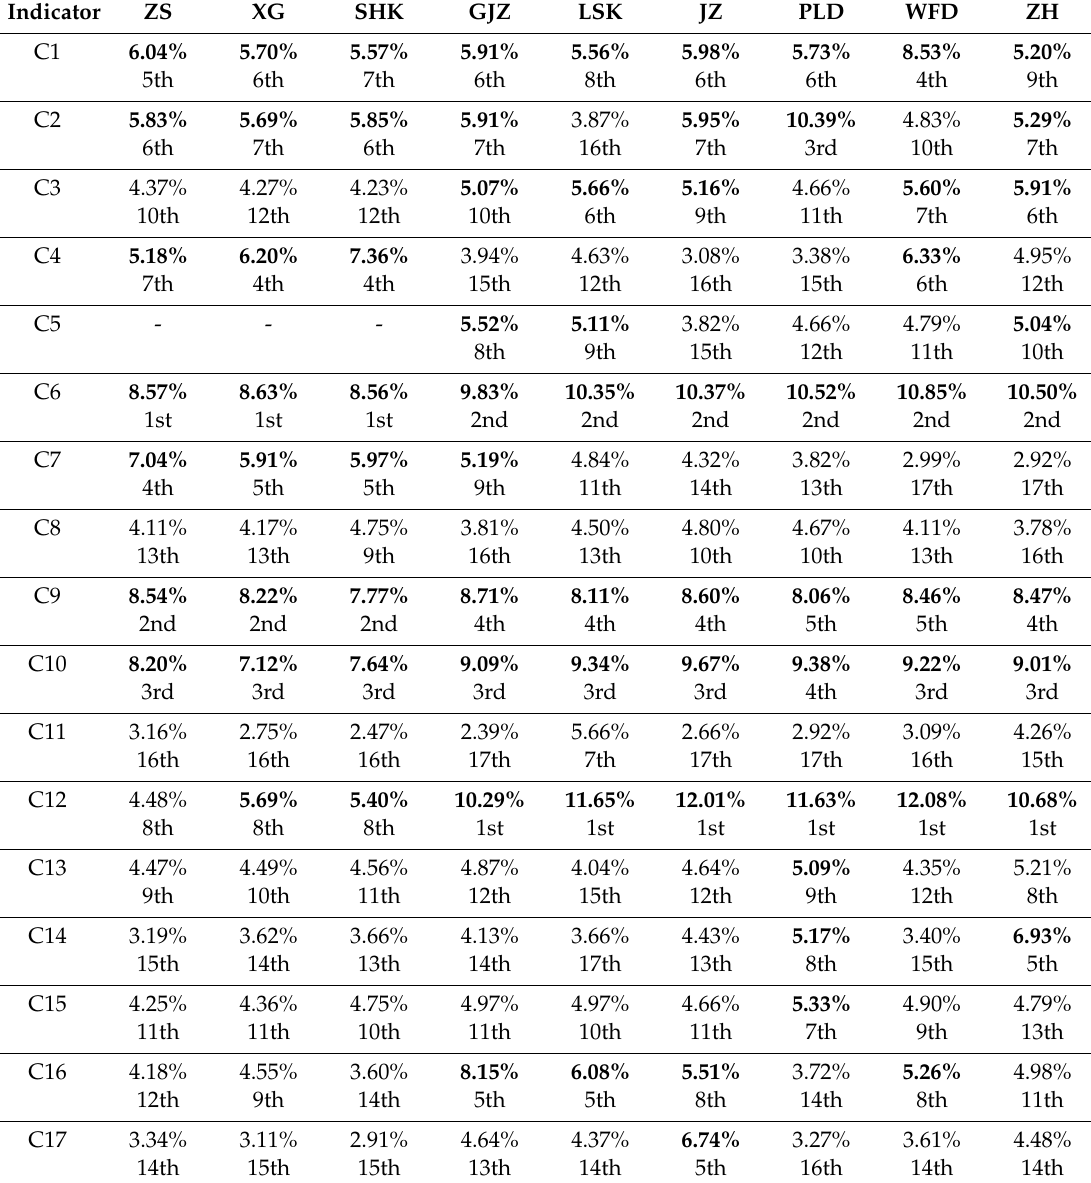
Table 4. Contribution of various indicators to medical